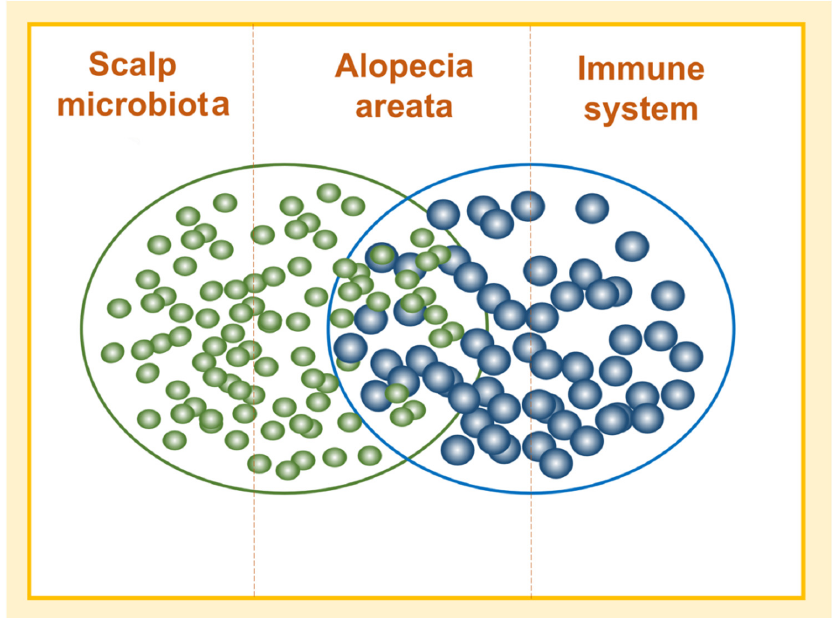
Figure 6. Microbiota and immunity crosstalk in alopecia